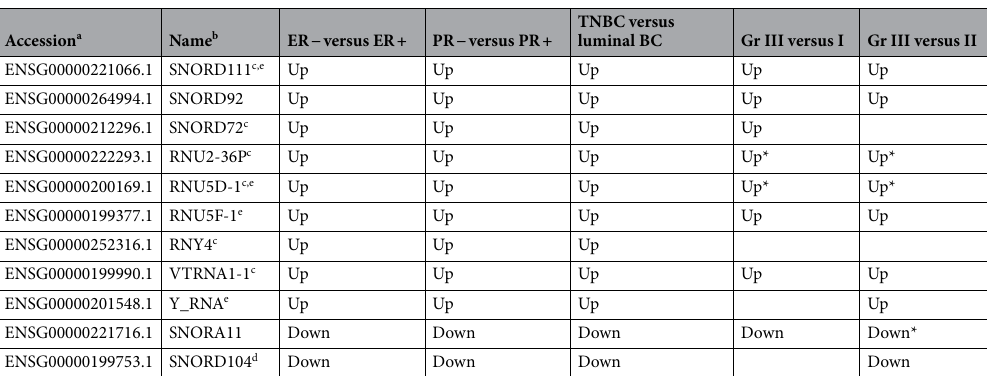
Table 1. The sncRNAs that were significantly DE ( Padj < 0.01) in the comparisons of hormone receptor status (ER negative vs. positive tumors and PR negative vs. positive tumors) and in the comparison between TNBC and luminal BC subtype indicating their potential role in invasive local BC. The significant associations ( Padj < 0.01) for these sncRNAs with tumor grade are also shown. The asterisk denotes the significant association with tumor grade also independently of the ER status. More information can be found in the Supplementary material. a Accession code from the ‘gene_id’ field from GENCODE. b Name from the ‘gene_name’ field from GENCODE. c Significantly upregulated also in invasive local BC compared to benign breast tissue. d Significantly upregulated also in metastasized BC compared to invasive local BC. e Note that the expression level of these RNAs was low. sncRNAs small non-coding RNAs, DE differentially expressed, Padj adjusted P -value, ER estrogen receptor, PR progesterone receptor, TNBC triple-negative breast cancer, Gr